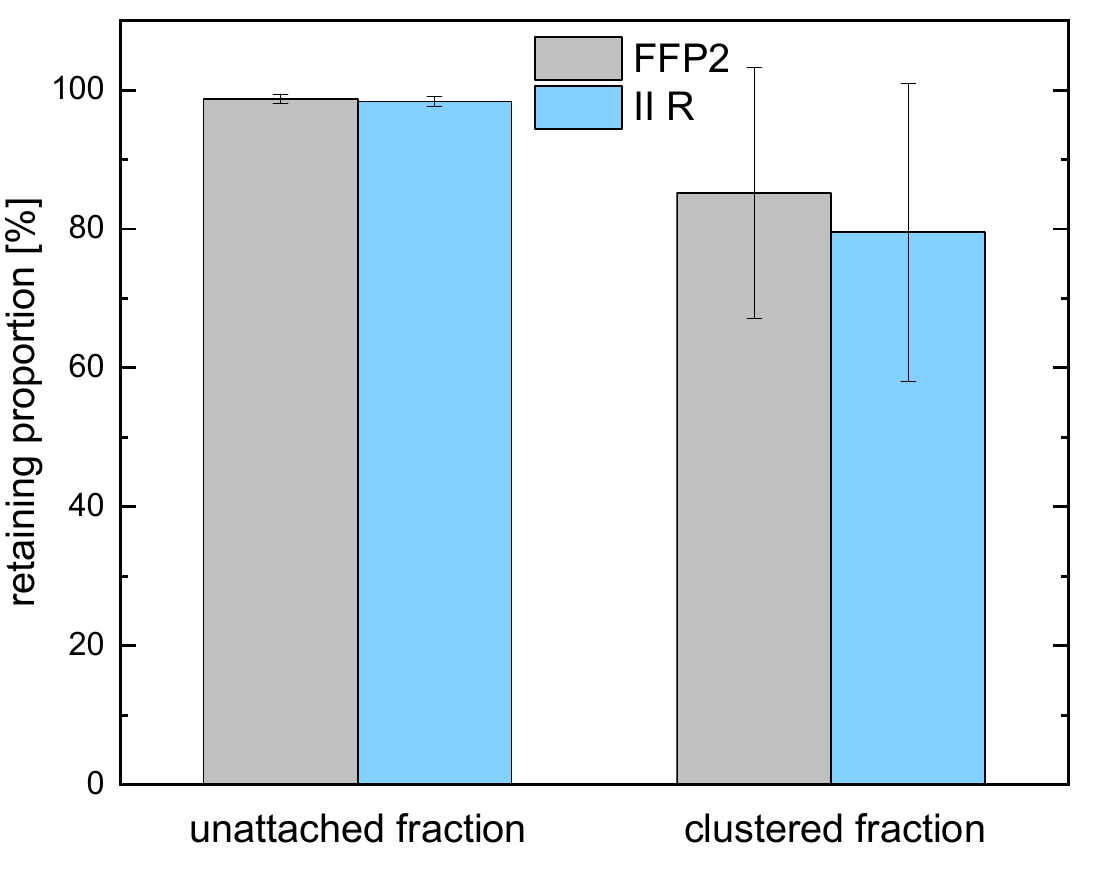
Figure 6. Retaining proportion of unattached and clustered fractions for FFP2 and II R masks in comparison to the measurement without a filter. The upper edge corresponds to the mean value, and errors are calculated by Gaussian error propagation. Table 3. Retained proportion for each size fraction and different mask.